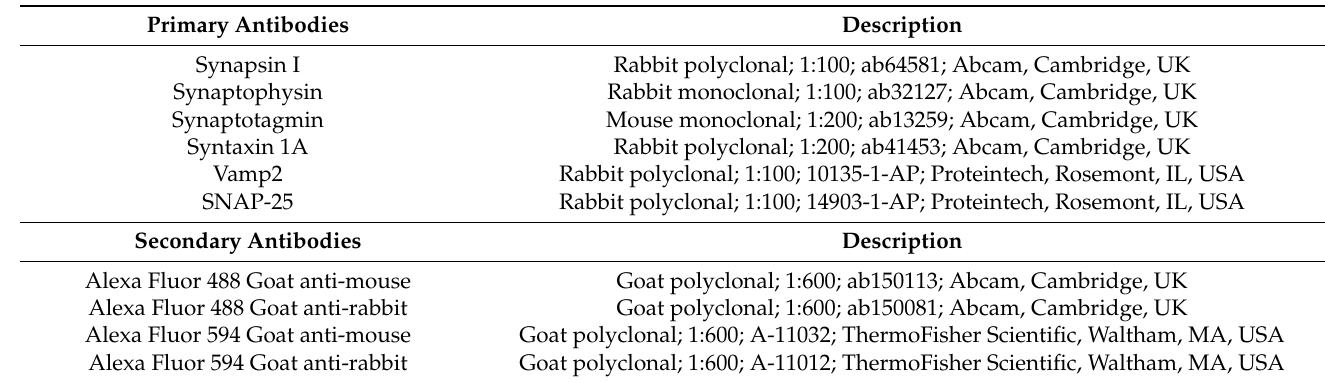
Table 3. Primary and secondary antibodies used for immunofluorescence